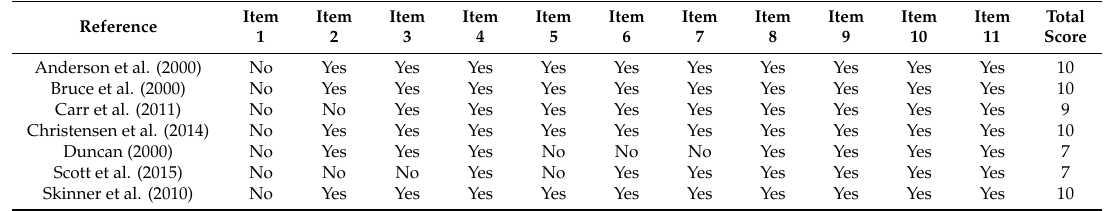
Table 2. Results of PEDro checklist quality assessment.